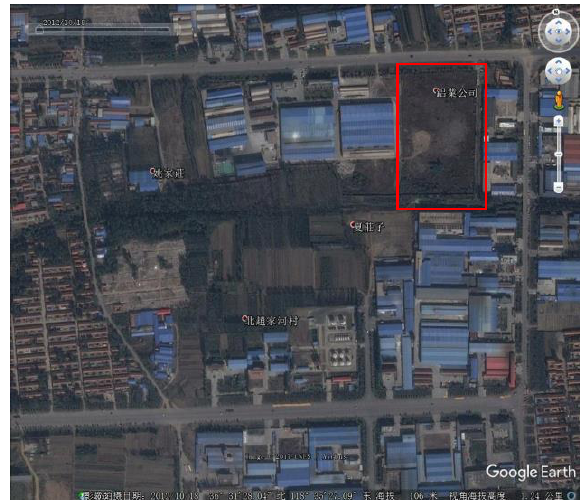
Figure 11. Available Google Earth images 2012 for